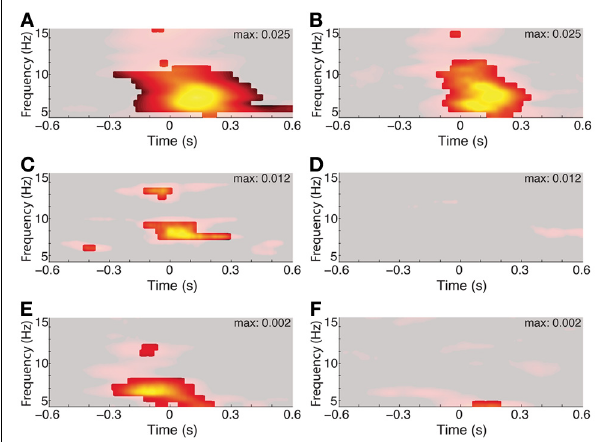
FIGURE 5 | Three to eight hertz phase alignment depends on visual search but not on matched-rate (3–6Hz) saccades. Left columns show full data and right columns the control condition. Significant PPC values are unmasked ( p < 0 . 001 of fixation-time-shuffled distribution and Rayleigh test p < 0 . 001 FDR corrected). (A) PPC from a single hippocampal recording site in a patient. (B) PPC from the same site, excluding all but fixations lasting > 500ms both before and after the fixation onset of interest. (C) Average PPC from Patient 6 during search in the constant-stimulus version task. (D) Average PPC from the same sites, but for fixations made on the dark screen during the inter-trial intervals. (E) Average PPC from the macaque hippocampus aligned to fixations occurring during the main-task trials, and the inter-trial interval on a black screen (F)